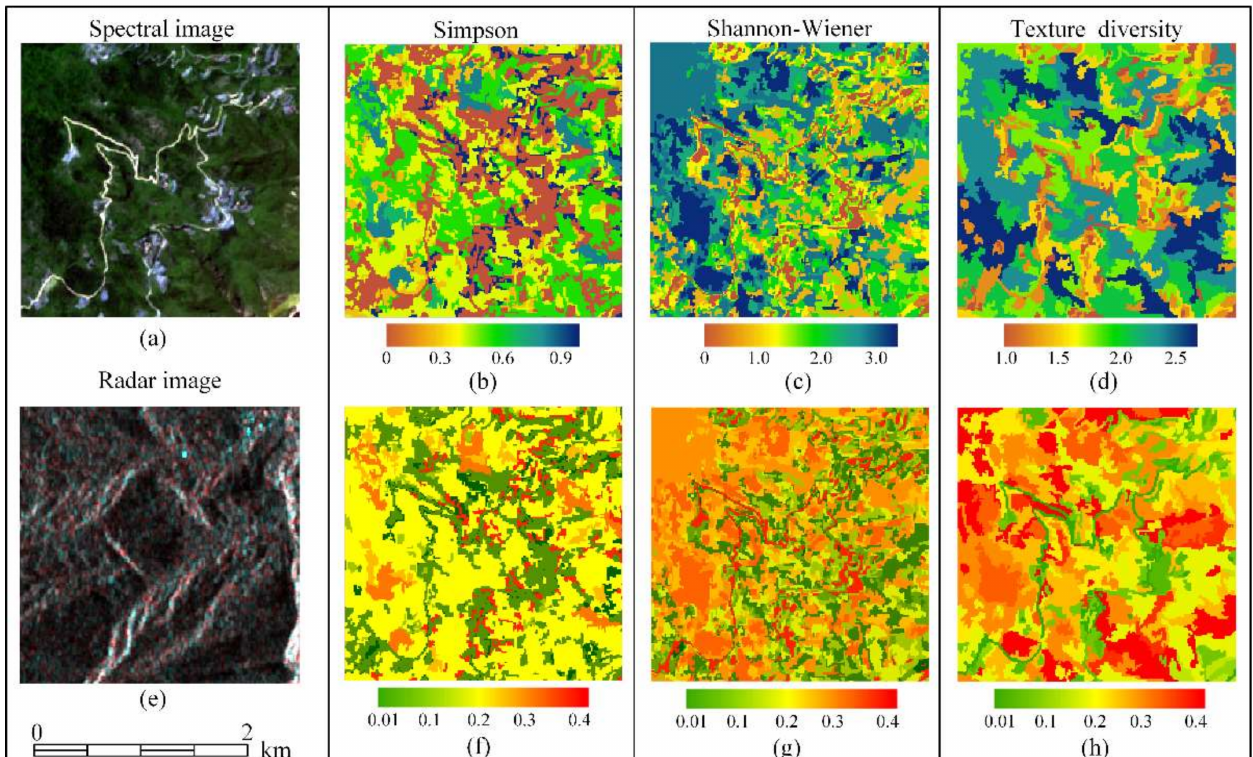
Figure 6. ( a ) Spectral and ( e ) radar images of the subtropical evergreen-deciduous broad-leaved mixed forest parcels around plot BGS-263. Predictions of the ( b ) Simpson, ( c ) Shannon-Wiener, and ( d ) texture diversity indices for pixels corresponding to these parcels. ( f – h ) correspond to the confidence intervals associated with the three respective predictions of diversity